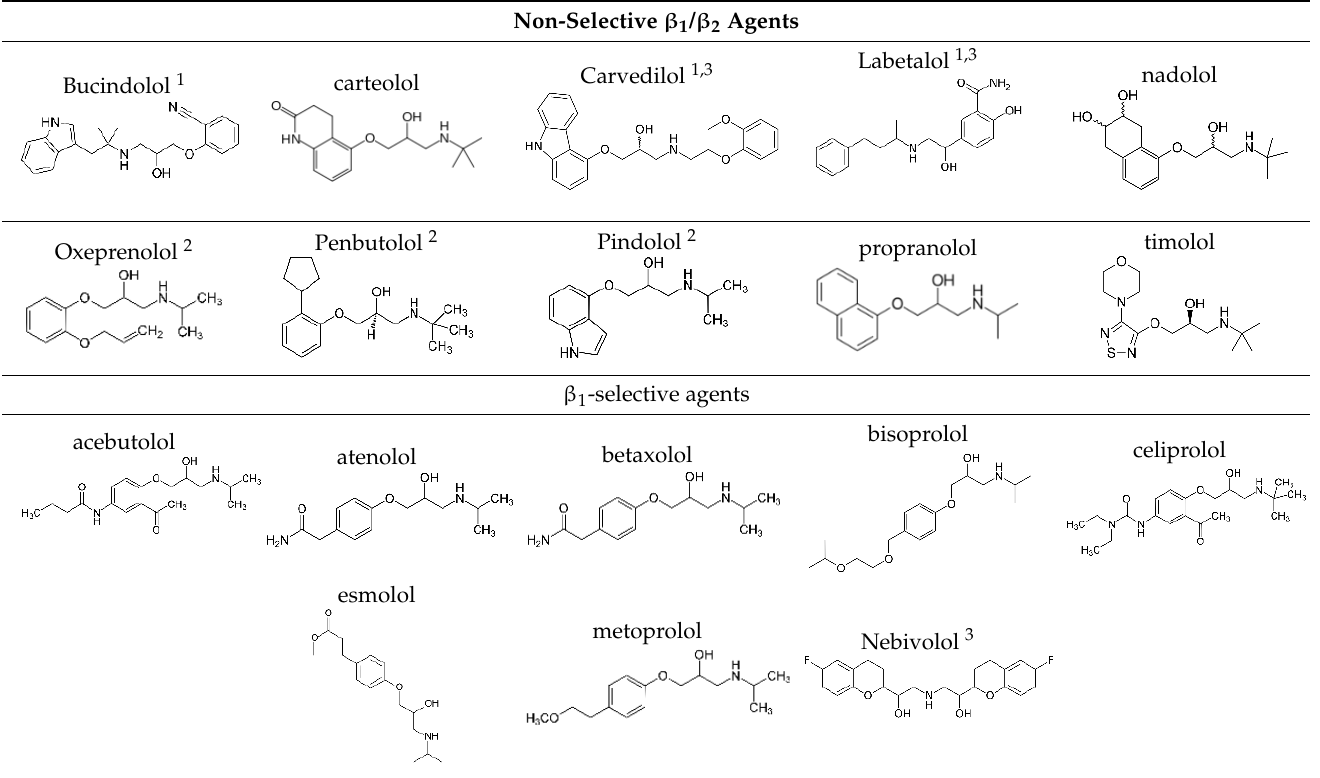
Table 1. Chemical structures of non-selective and selective β-blockers.